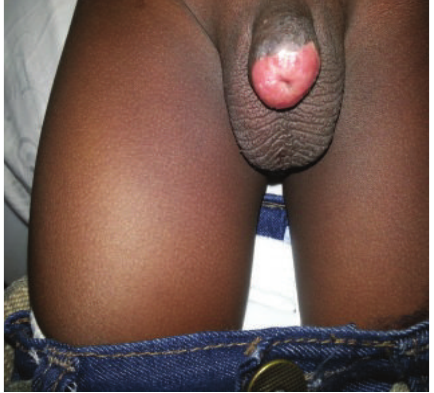
Figure 9: Glans penis at six months (AP